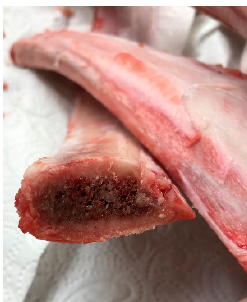
Figure 1. The part of the ribs which was similar to type 4 was used in the study.